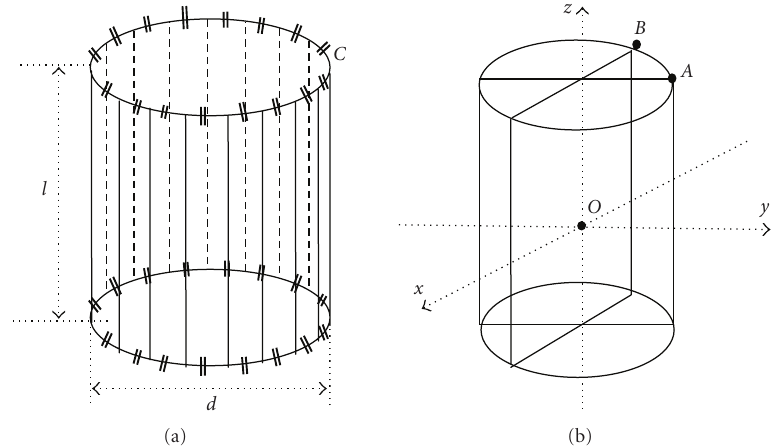
Figure 1: (a) Structure of a high-pass birdcage head coil showing a schematic view of the coil and (b) coronal and sagittal planes of the coil, where “ l ”: length of the coil; “ d ”: diameter of the coil; “ C ”: capacitor; “ A ” and “ B ”: RF feeding points; “ O ”: center of the